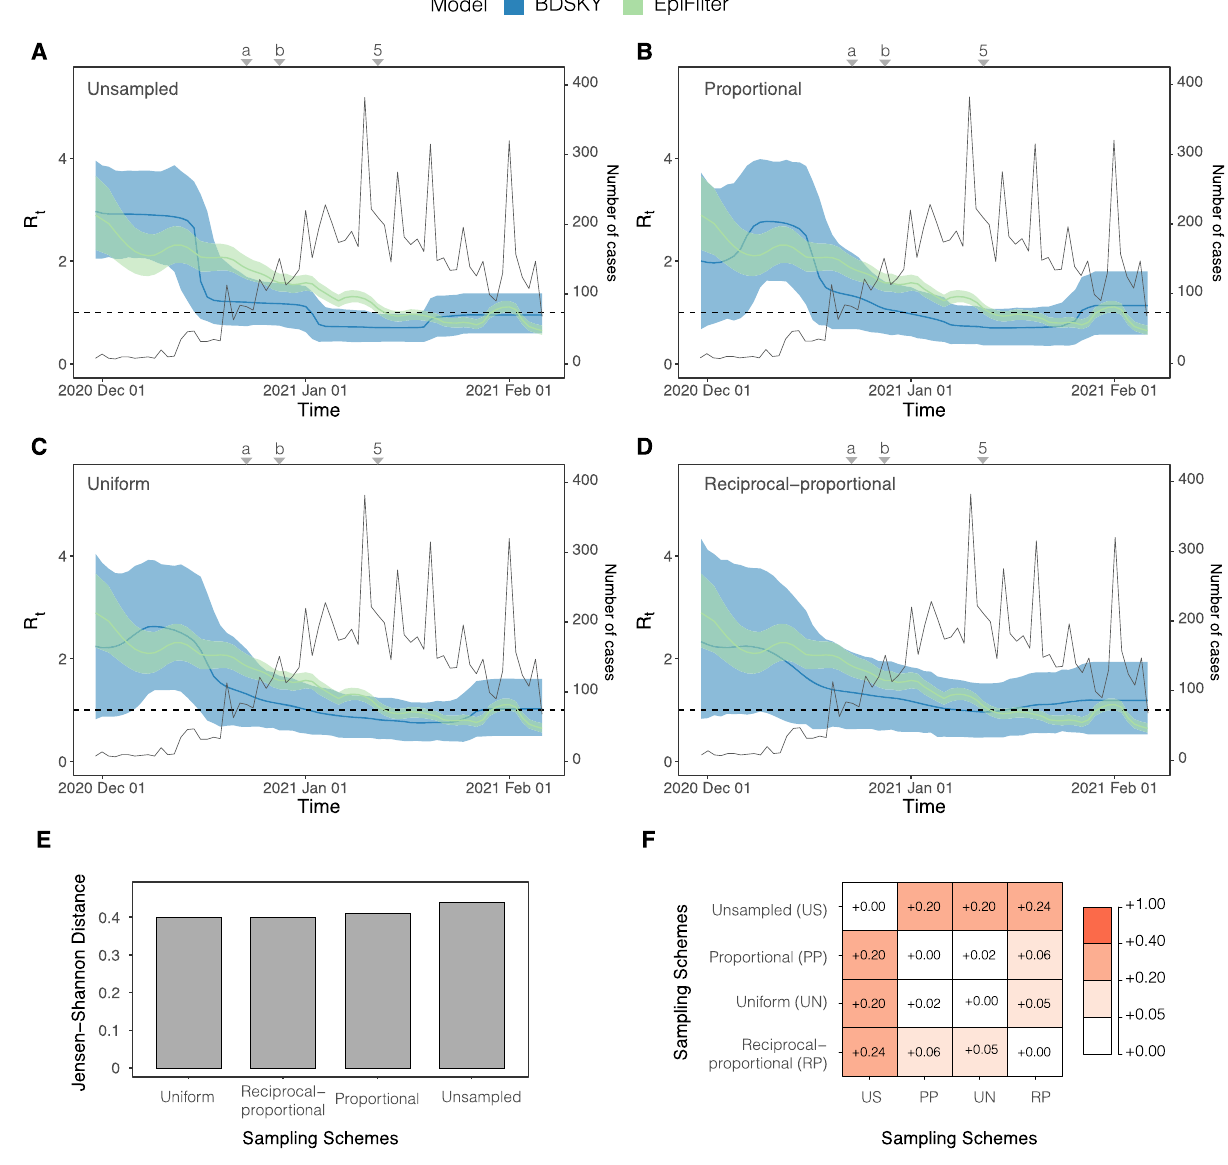
Fig. 6 | R t estimated from both the Birth Death Skyline (BDSKY) and EpiFilter methodsforAmazonas,Brazil. Titlesindicatethesamplingschemeusedinpanels A – D . The light-shaded area represents the 95% highest posterior density interval. The solid line represents the mean R t estimate with EpiFilter in green and BDSKY in blue. We refer to Fig. 2 for a brief description of key events, including 5 which corresponds to the second lockdown. Event “ a ” corresponds to the suspension of commercial activities in Manaus; event “ b ” corresponds to the resumption of